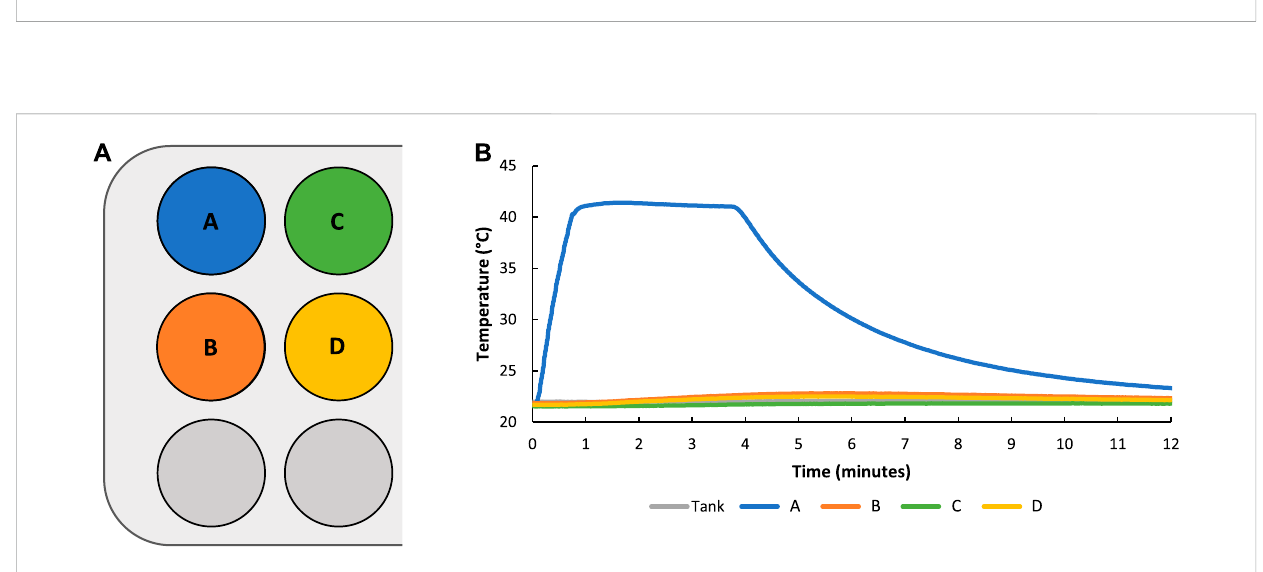
FIGURE 7 Graphic showing naming convention and location of hydrogels in sample holder wells with hydrogel A being targeted with FUS controlled heating (A) .During FUS targeted heatingof sample A minimal heating ofhydrogels inother sample holder wells ( ≤ 1 ° C)was observed showingtight spatial control of FUS heating (B)